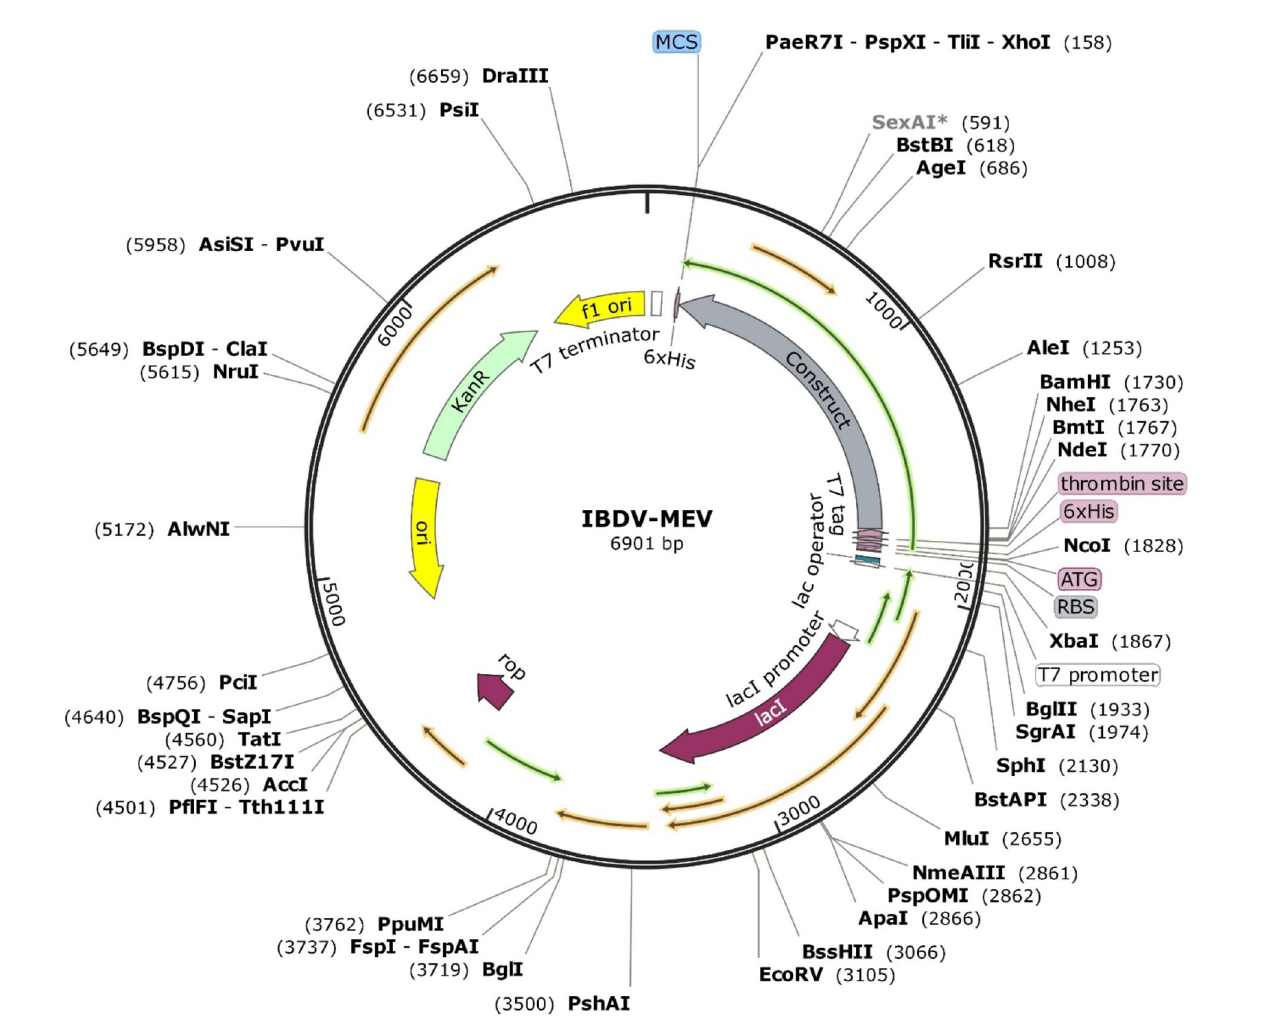
FIGURE4 In silico restriction cloning of the optimized sequence of the designed MEV into the pET28a( + ) expression vector. The MEV construct is labeled as Construct, and the restriction sites are incorporated at N-terminal ( XhoI ) and C-terminal ( BamHI ) of the vaccine